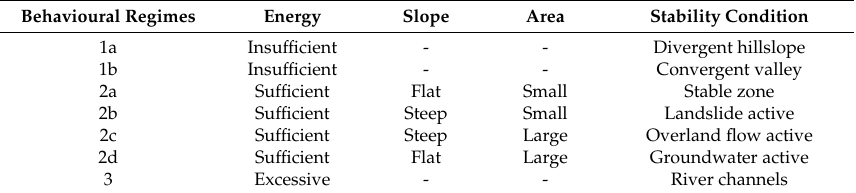
Table 1. Stability condition of slope–area behavioural regimes based on channel